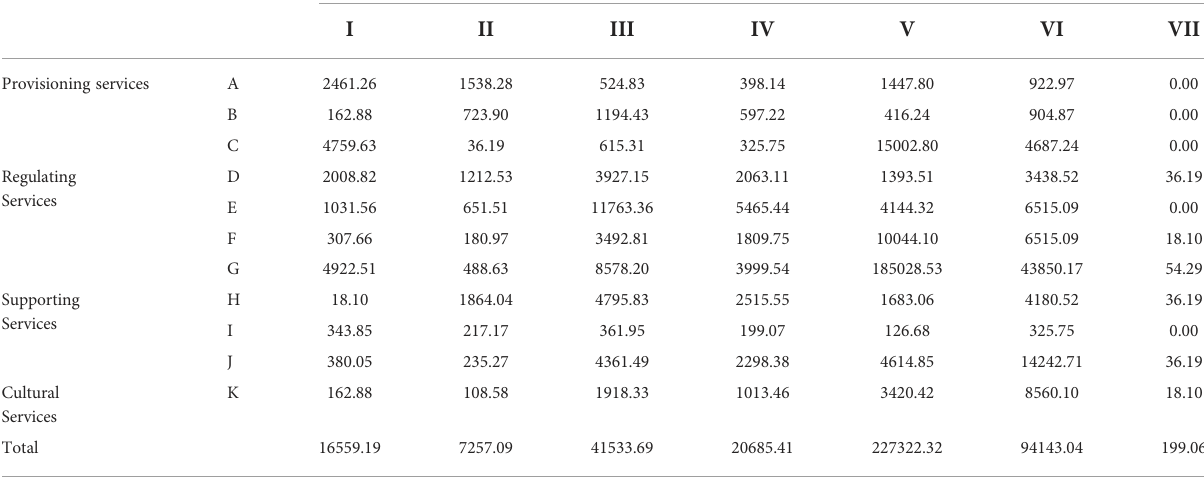
TABLE A2 Ecosystem service value per unit area. Ecosystem